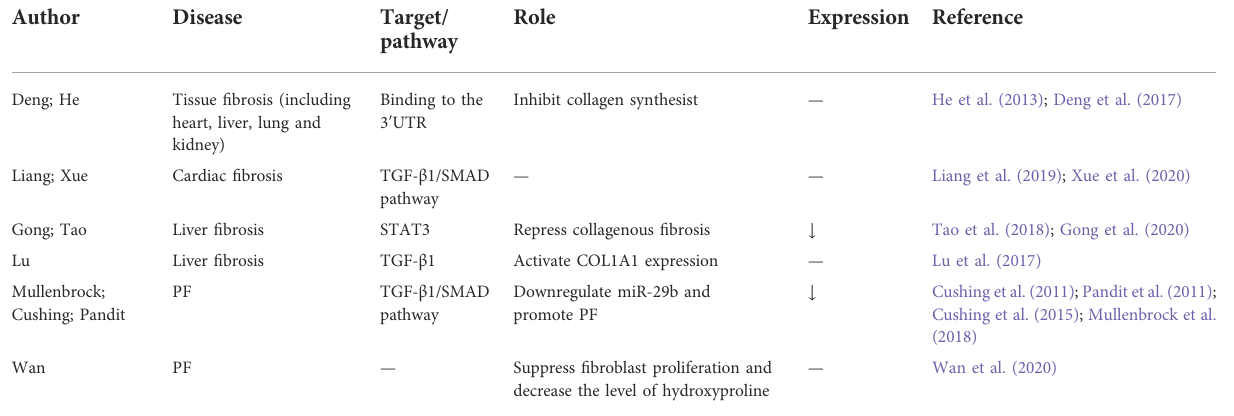
TABLE 7 The roles of miR-29b-3p in lung